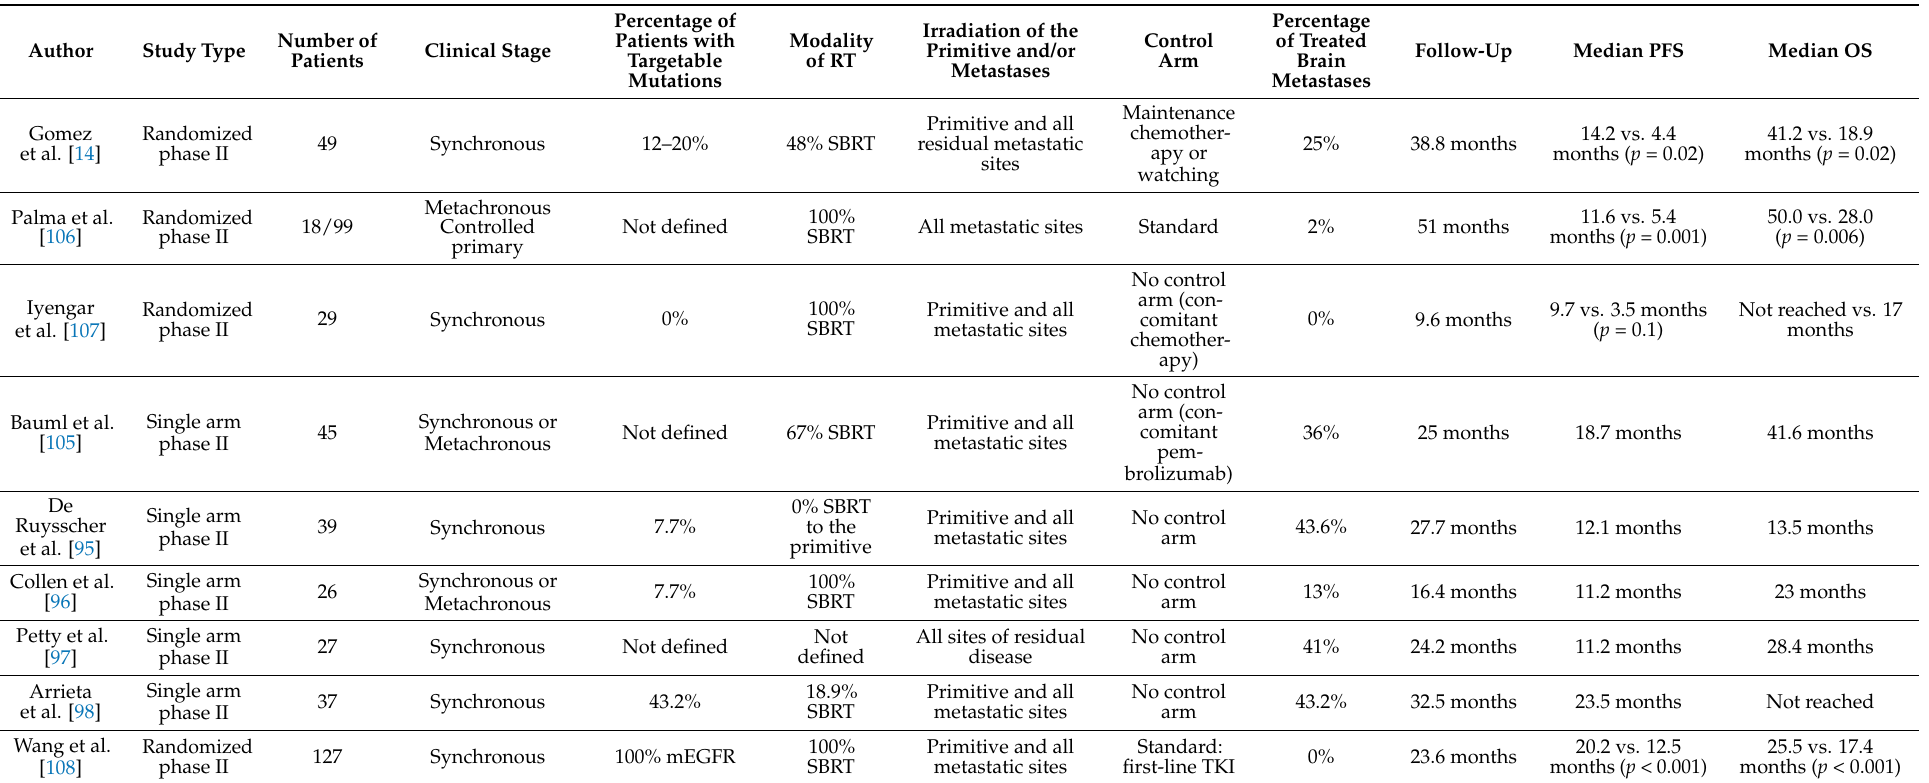
Table 5. Prospective studies of consolidative radiotherapy in metastatic NSCLC patients, irrespective of the mutational